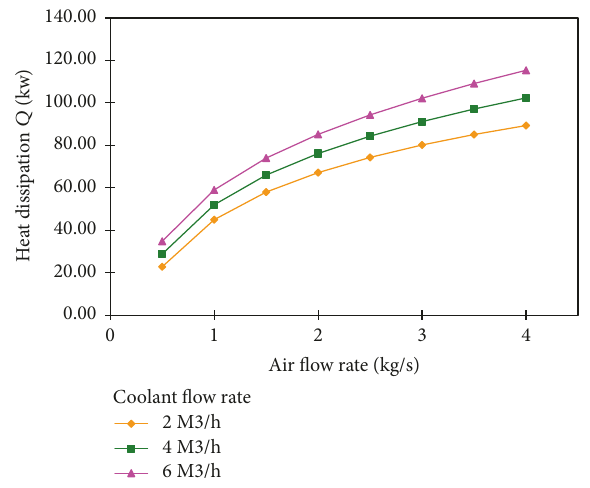
Figure 2: Heat dissipation ability of the radiator and